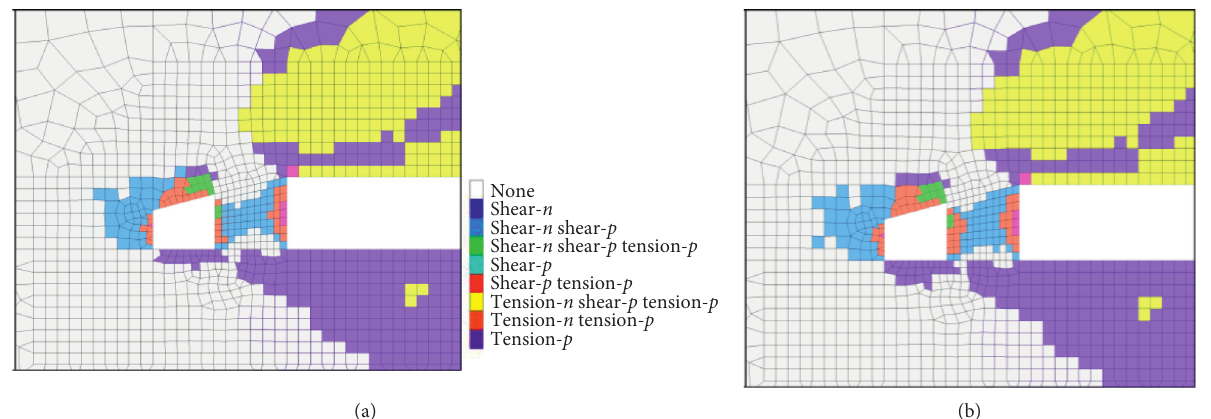
Figure 7: Distribution of the plastic zone of the rock during the airway excavation. (a) 150m from the cutting hole and (b) 180m from the cutting hole.